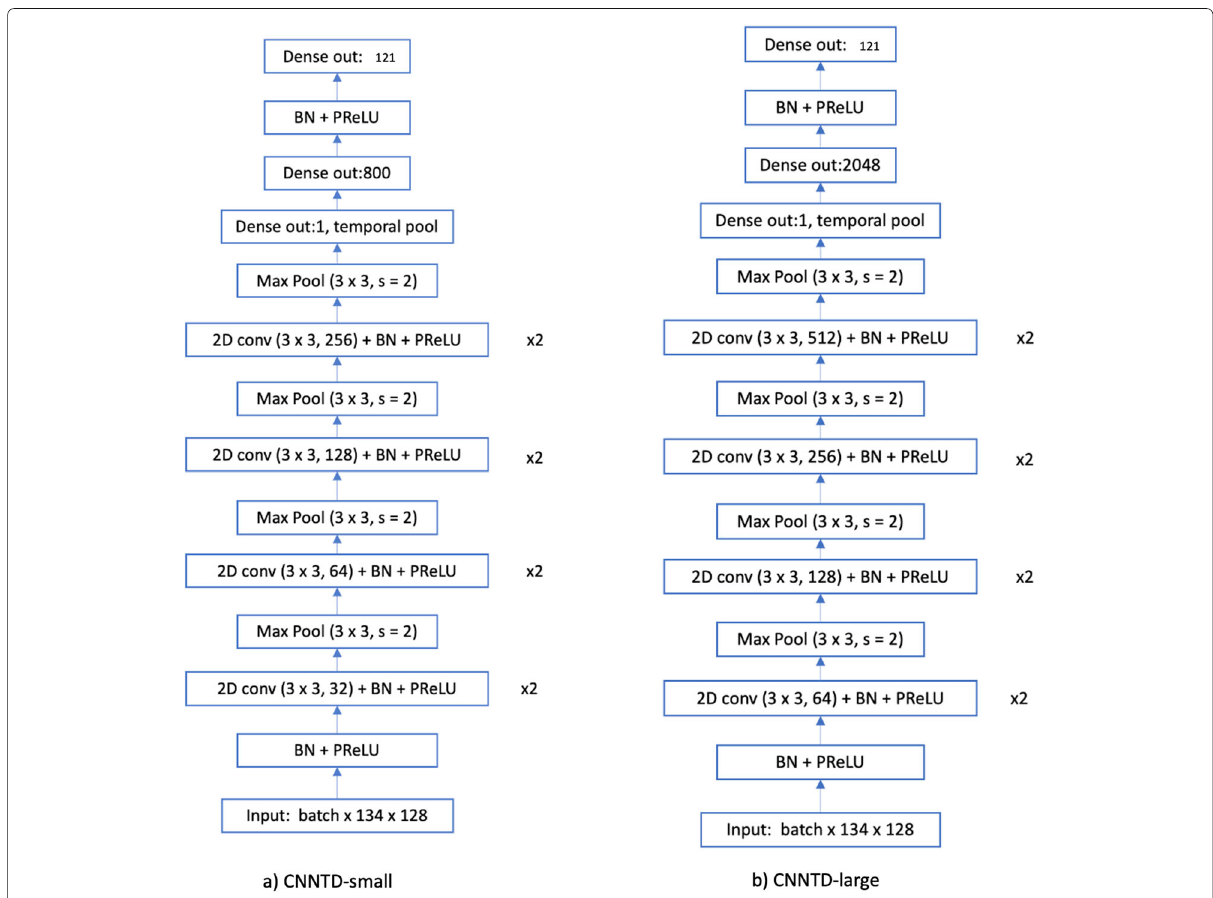
Fig. 3 CNNTD-small and CNNTD-large model architectures